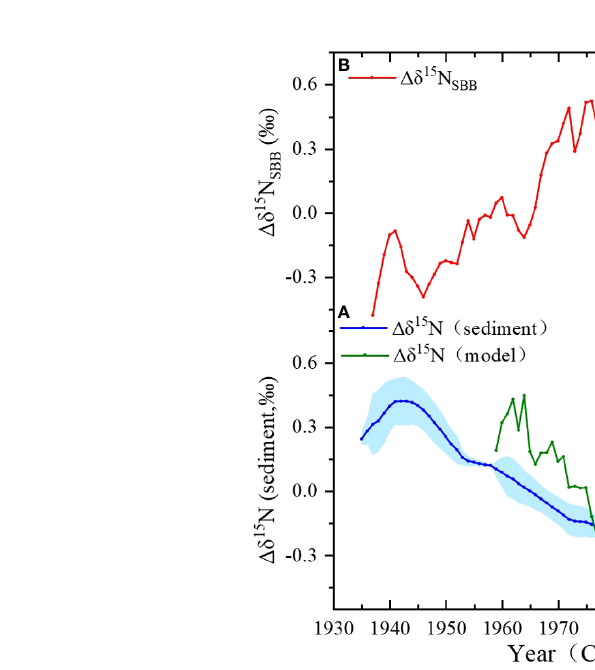
FIGURE 6 Calculation of ETNP Dd 15 N and Dd 15 N SBB . (A) Construction of the eastern tropical North Paci fi c (ETNP) Dd 15 N signal, the blue curve shows the result of the average Dd 15 N from Soledad and Pescadero sites, and the green curve shows the result of the model. (B) The calculated Dd 15 N SBB (red